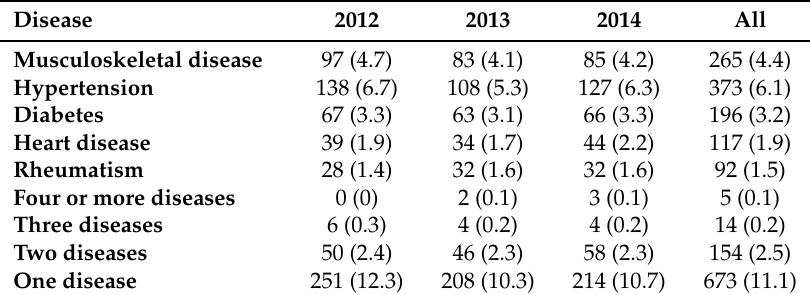
Table 5. Prevalence of diseases.